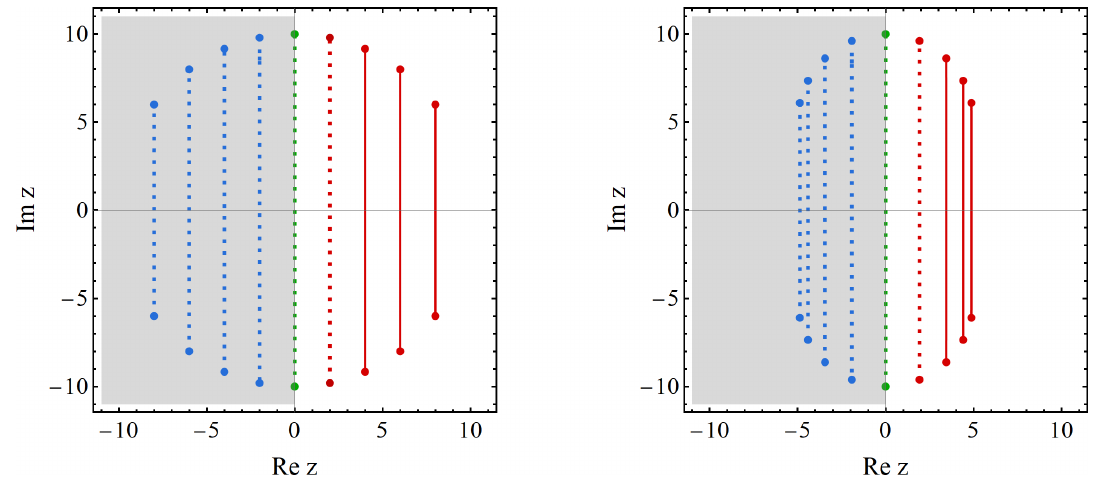
Figure 20 . The Stokes lines for spin-1 bosons (left panel) and spin-1/2 fermions (right panel) in radiation-dominated universe. In both panels, the mass is set to ˜ m = 0 . 1 , and the momentum k is fixed to have a dimensionless chemical potential ranging over ˜ κ = − 0 . 08 , − 0 . 06 , · · · , 0 . 06 , 0 . 08 (from left to right, and the green lines correspond to the case without chemical potential). The gray region with Re z < 0 cannot be reached physically. Solid lines represent scenarios where the Ginzburg criterion (4.70) is fulfilled and vacuum initial condition is satisfied, while dotted lines can only be understood in the analytically continued